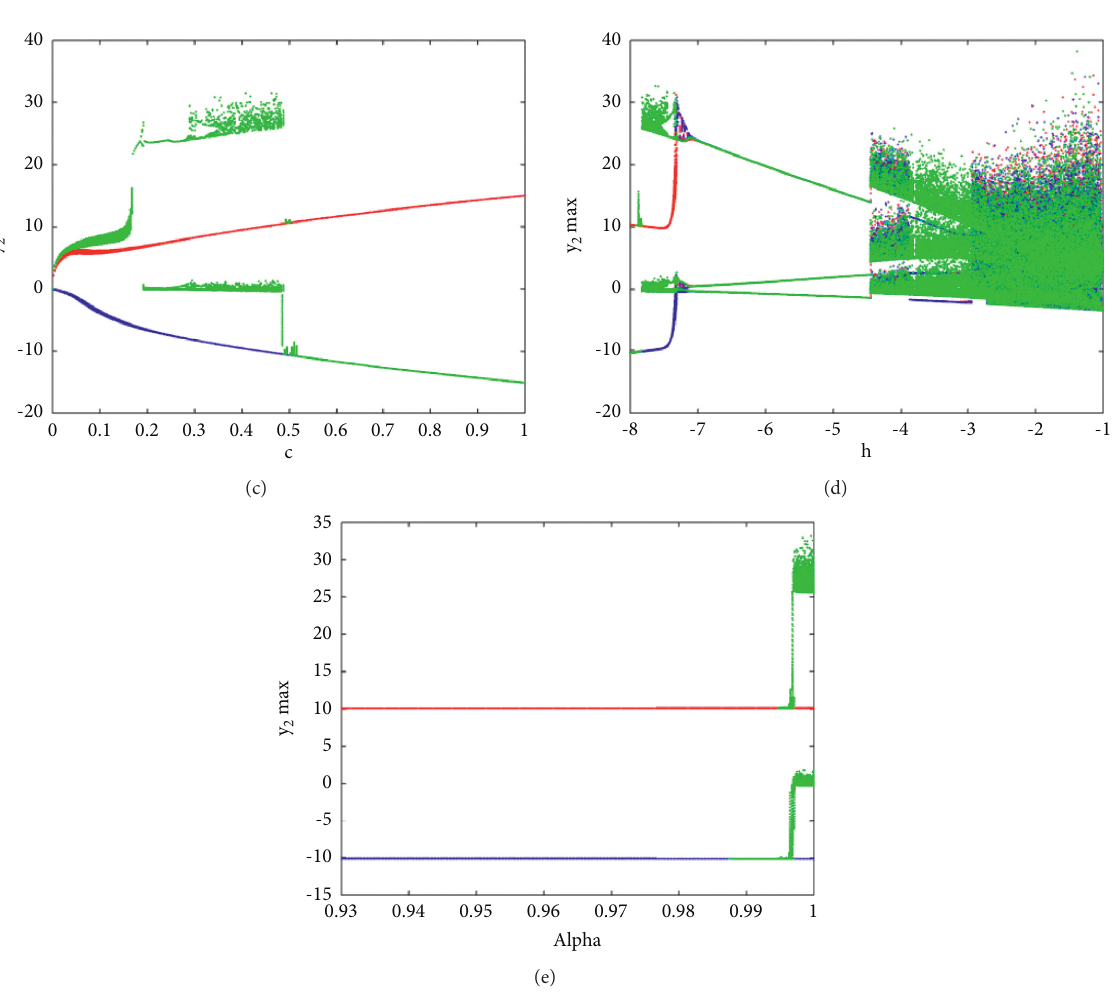
Figure 14: The bifurcation diagrams of the fractional-order Matouk’s system with α � 0 . 998, varying one parameter and fixing the others and using initial conditions ( 0 . 01 , 0 . 01 , 0 . 01 , 0 . 01 ) (green domain), ( 2 . 7 , 10 . 6 , 15 , 0 . 0001 ) (red domain), and according to the set A 2 (− 2 . 7 , − 10 . 6 , 15 , 0 . 0001 ) (blue